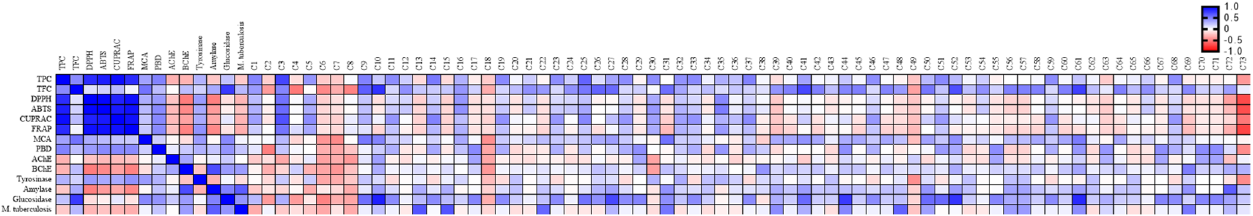
Figure 1. Correlation analysis of the phytochemical composition and biological activities. ABTS, 2,2′ -azino-bis (3-ethylbenzothiazoline) 6-sulfonic acid; AChE, acetylcholinesterase; BChE, butyryl- cholinesterase; CUPRAC, cupric ion reducing antioxidant capacity; DPPH, 1,1-diphenyl-2- picrylhydrazyl; FRAP, ferric ion reducing antioxidant power; MCA, metal chelating activity; PDA, phosphomolybdenum activity; TPAC, total phenolic acid content; TPC, total phenolic content. Compounds numbered as in Table 2.